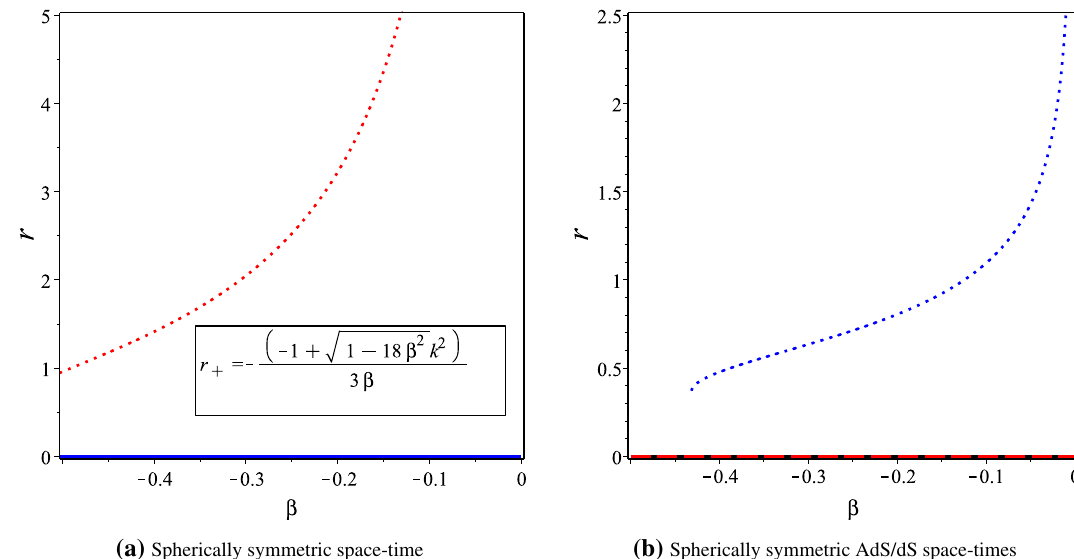
(b) Spherically symmetric AdS/dS space-times